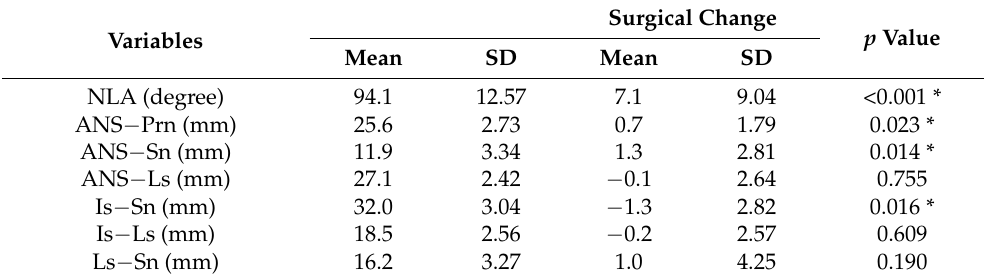
Table 3. Preoperative characteristics (angle and distances) and surgical change ( n = 33). Variables